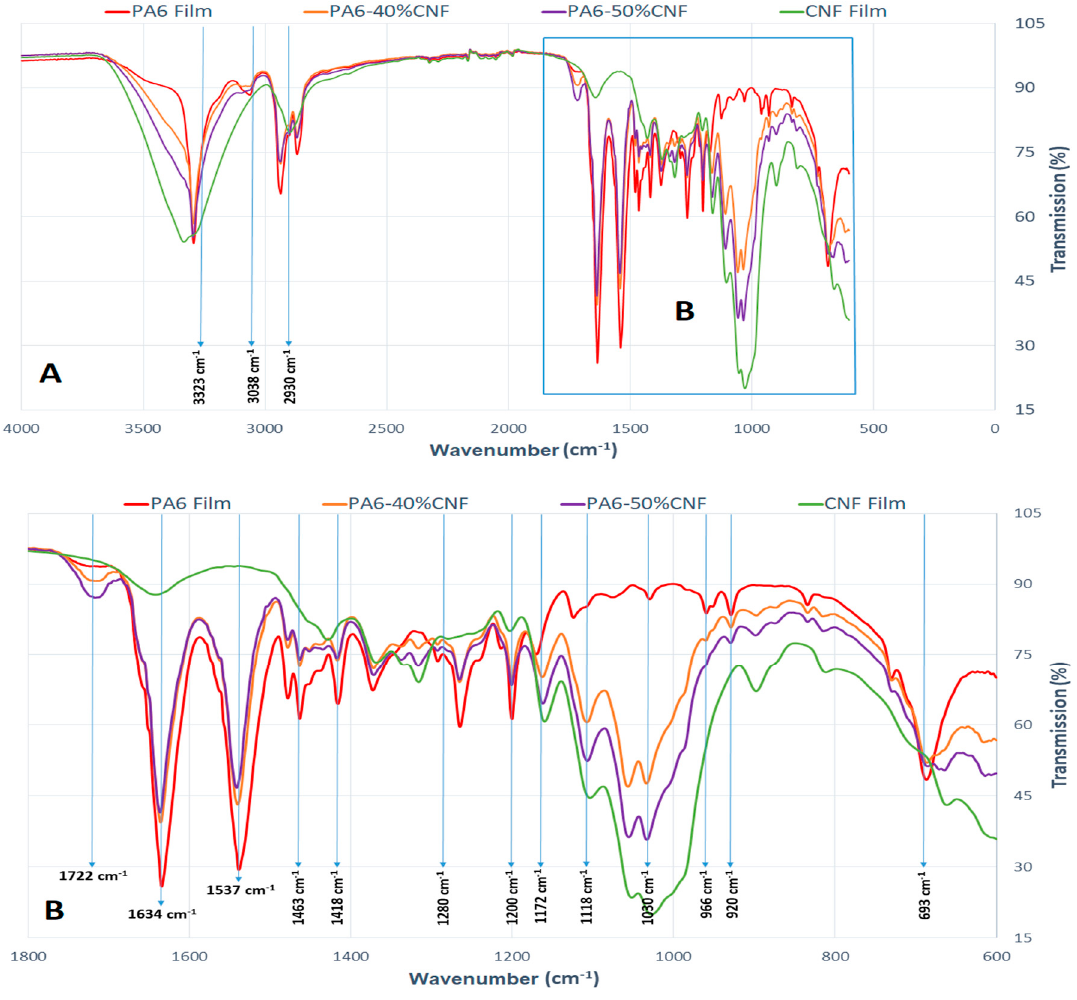
Figure 5. ( A ) FTIR spectra and ( B ) enlarged portion of the FTIR spectra at a lower wavelength for PA6 film, CNF film, and 40% and 50% formulation nanocomposite films.